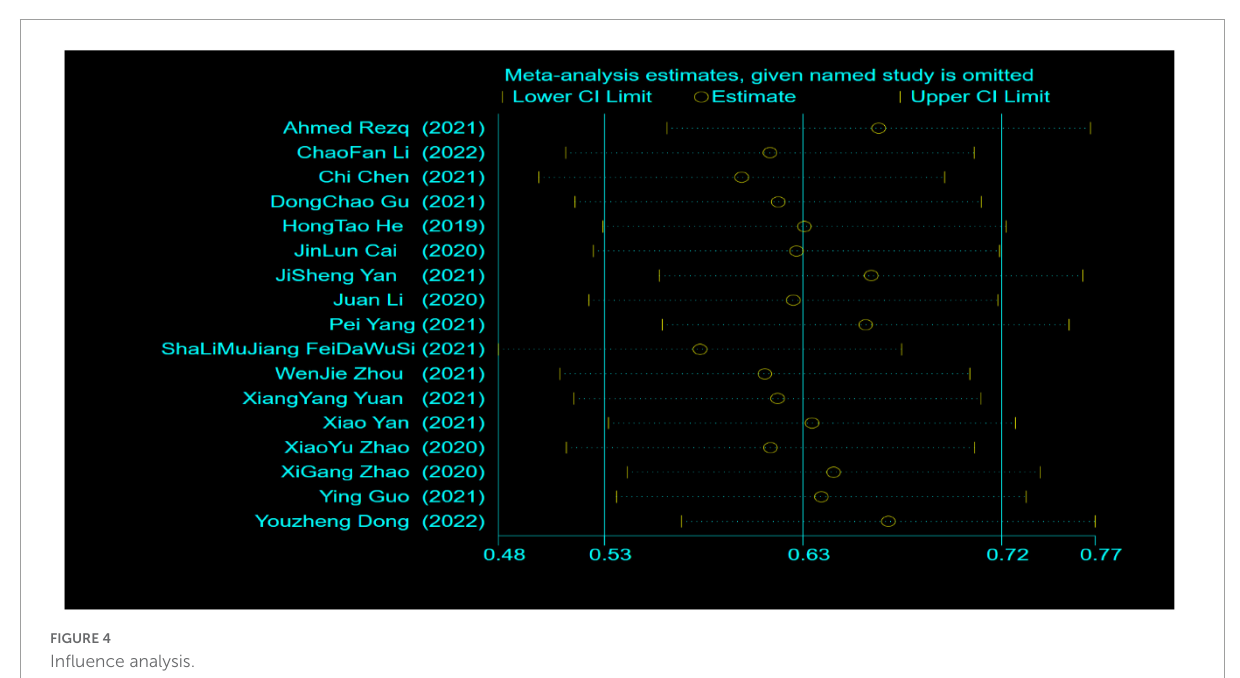
FIGURE4 Influence